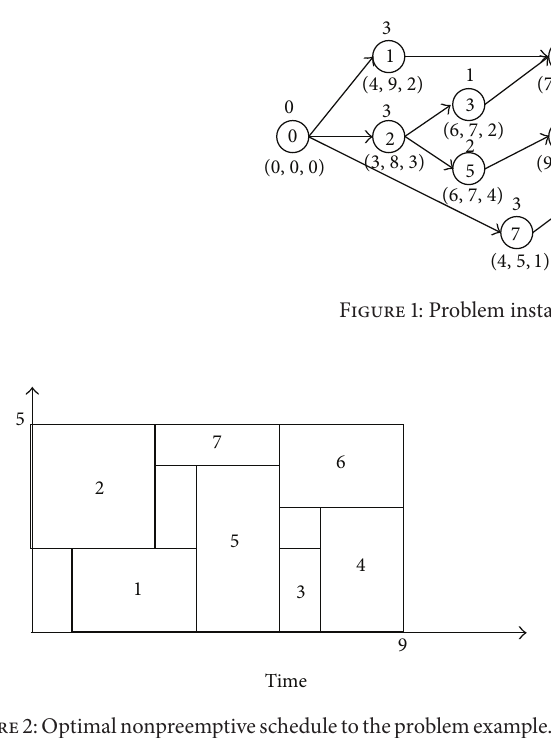
Figure2:Optimalnonpreemptivescheduletotheproblemexample.